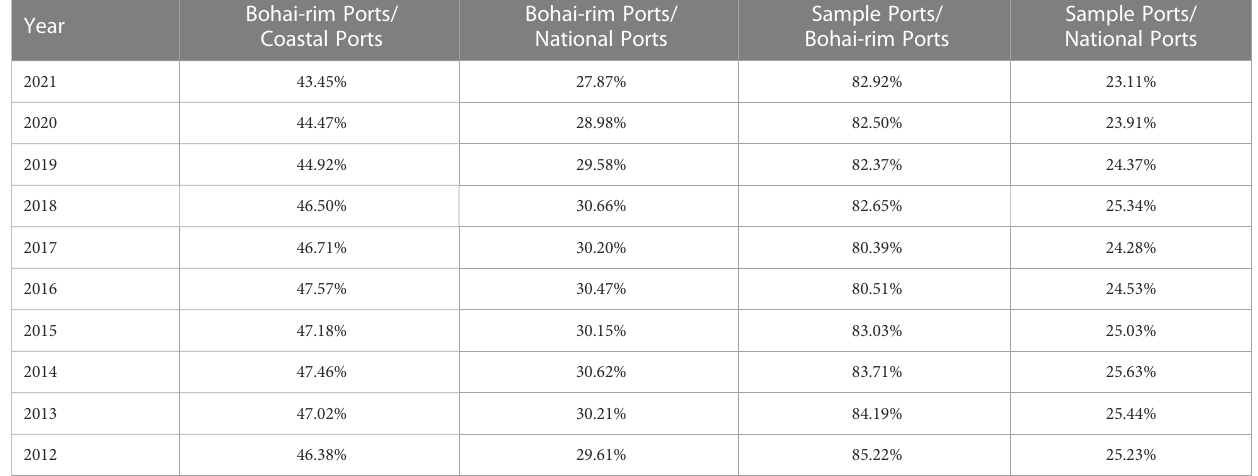
TABLE 1 Comparison of port cargo